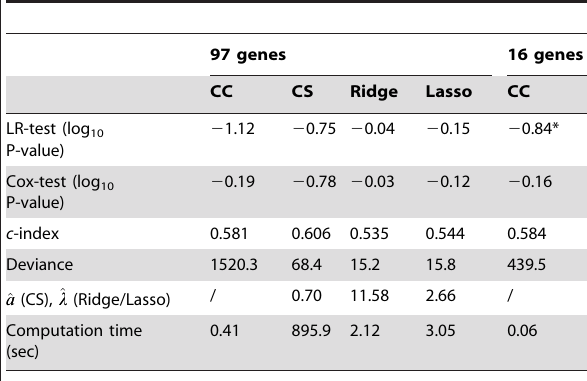
Table 4. Performance of the five methods based on the non- small-cell lung cancer data of Chen et al.